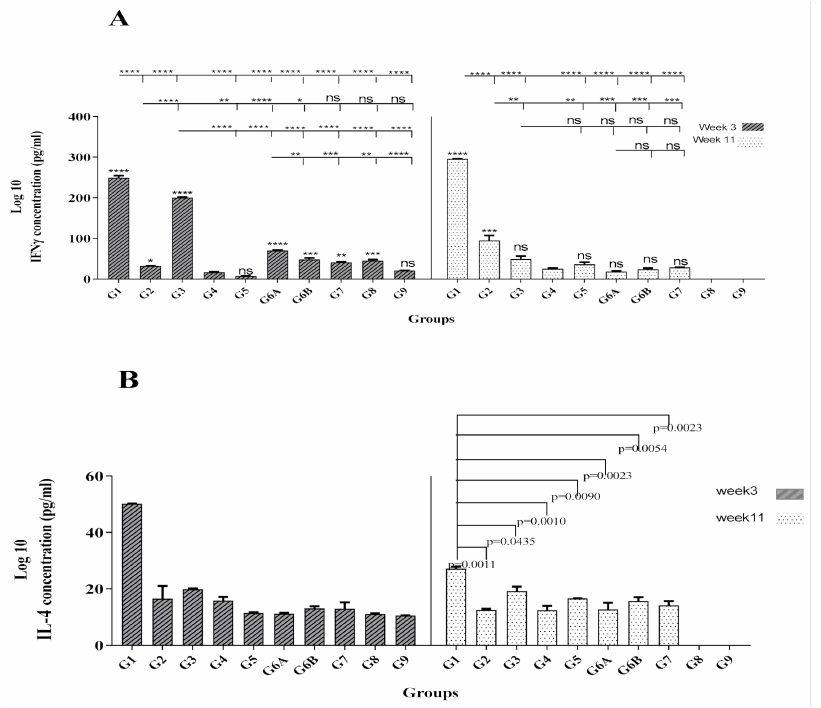
Figure 3. Analysis of cytokine profile in vaccinated and control mice groups. Splenocytes of mice were isolated at 3 and 11 weeks after the last immunization and stimulated by either rCore-rNS3 proteins (5 µ g/mL) or Con A (5 µ g/mL) for three and five days. Subsequently, IFN- γ ( panel A ) and IL-4 ( panel B ) levels in cell supernatants were measured by ELISA. All assays were performed in duplicate and at least three mice. Bars represent mean values, and SEM are expressed in pg/mL. Statistical analyses were done by one-way ANOVA ( p < 0.05 denoted as *, p < 0.01 denoted as **, p < 0.001 denoted as ***, p < 0.0001 denoted as **** and non-significant denoted as ns). The asterisks indicated directly above the bars demonstrate statistically significant differences between the vaccinated groups and the control group of mice